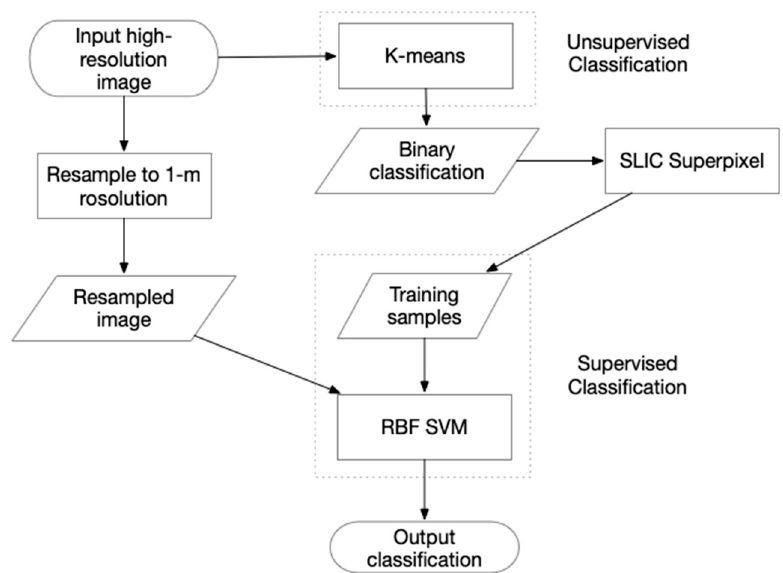
Figure 7. The workflow of the proposed k-means support vector machine (KMSVM) method. KMSVM makes use of unsupervised clustering and the superpixel algorithm to select training data for SVM classification.